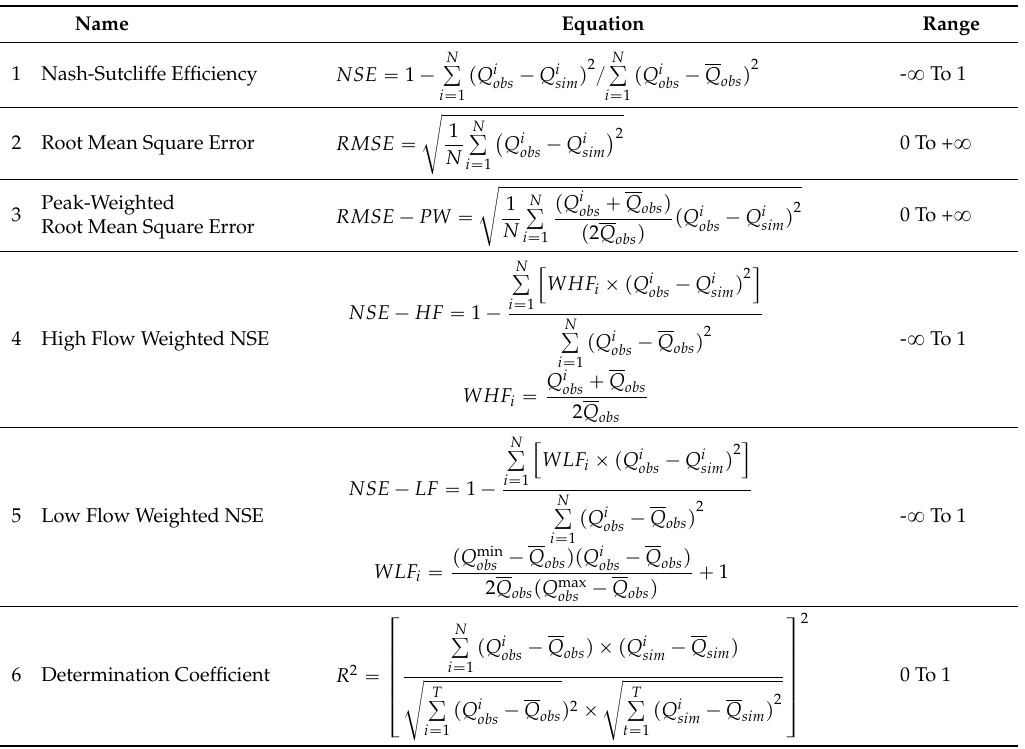
Table 3. Goodness of fit indices to compare the